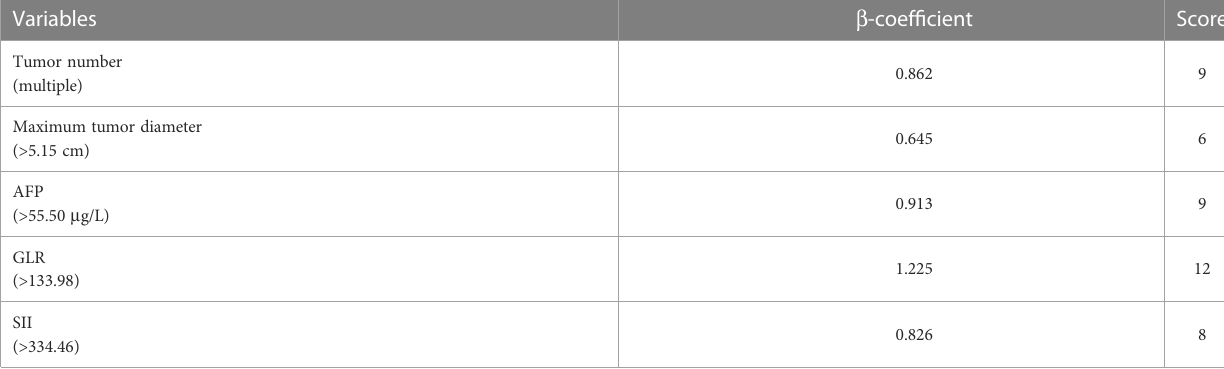
TABLE 4 Scores for independent risk factors of tumor recurrence.